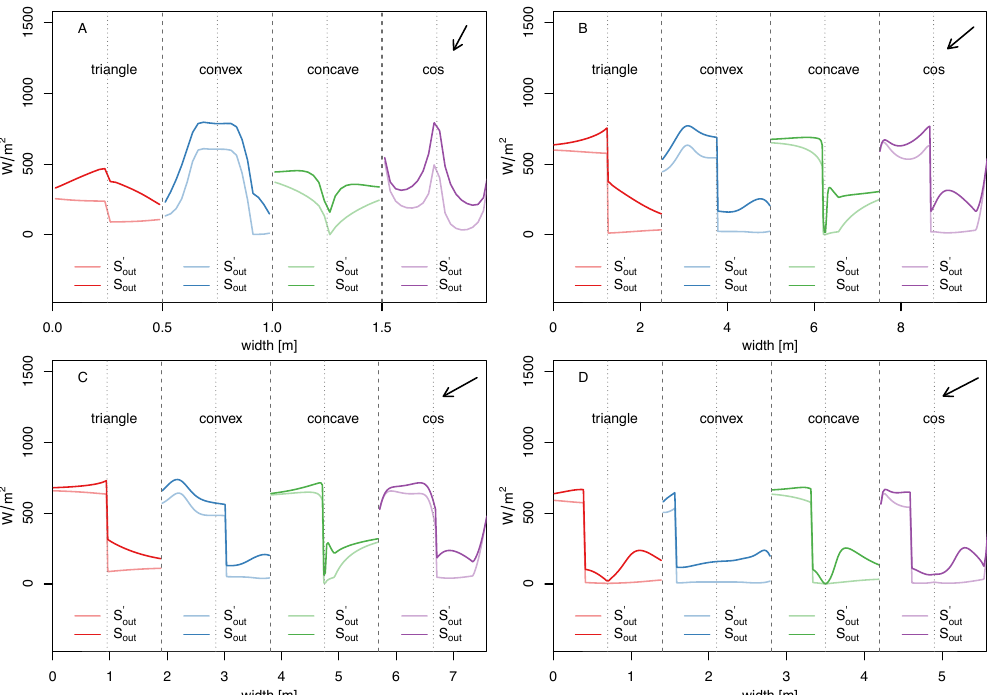
0 out , respectively) along a penitente surface for a